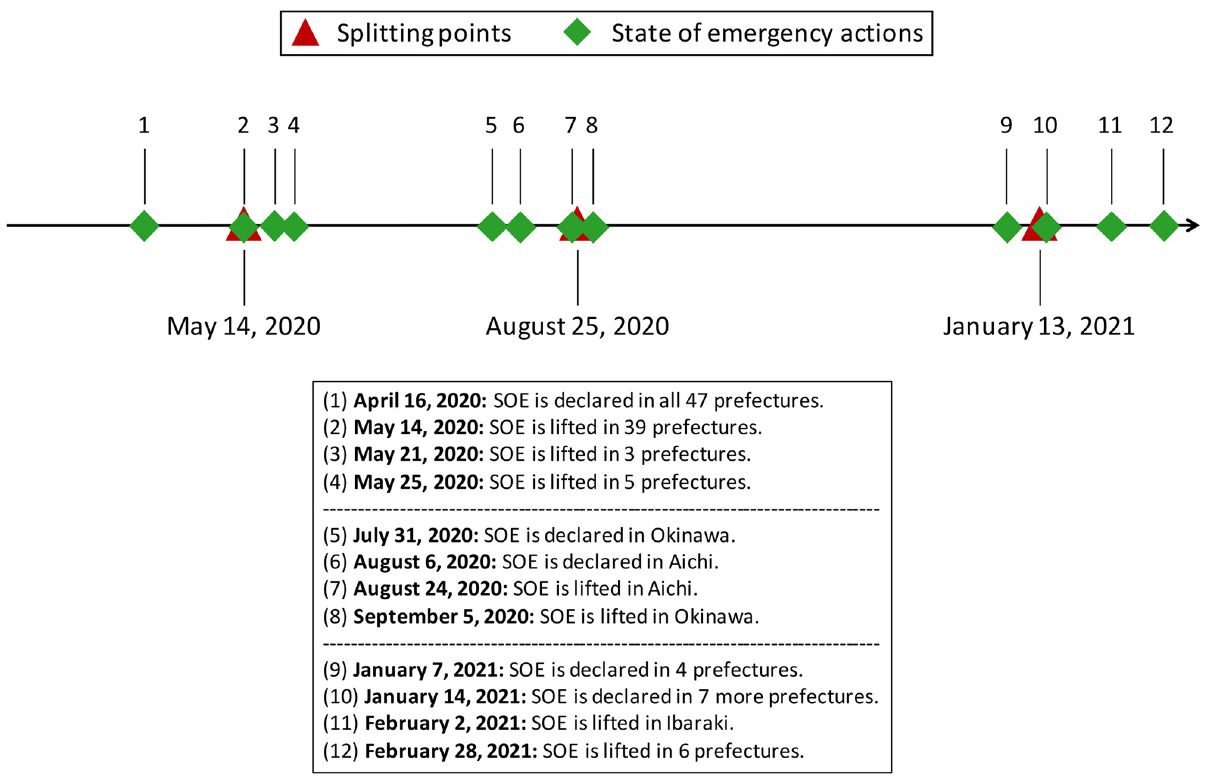
Fig 4. Our proposed segmentation scheme captures policy changes. Splitting points detected by our segmentation scheme coincide with the periods when the state of emergency (SOE) was declared or lifted by the Japanese Government. Note that such events happened 12 times in total during the considered period, and all of them are marked in the